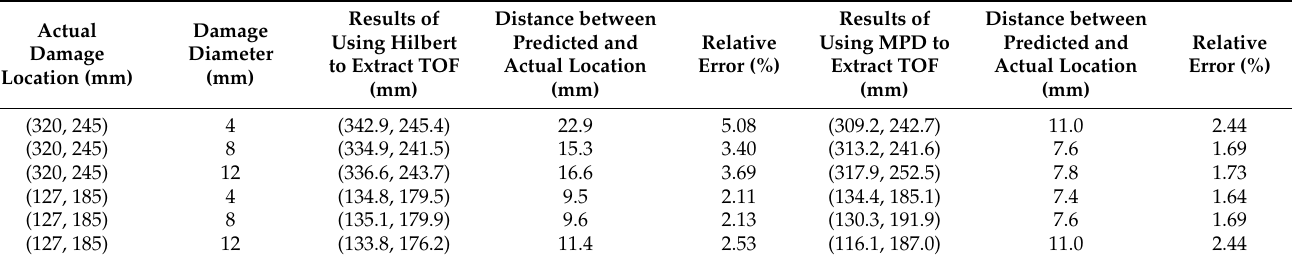
Table 2. Damage center prediction results and errors.